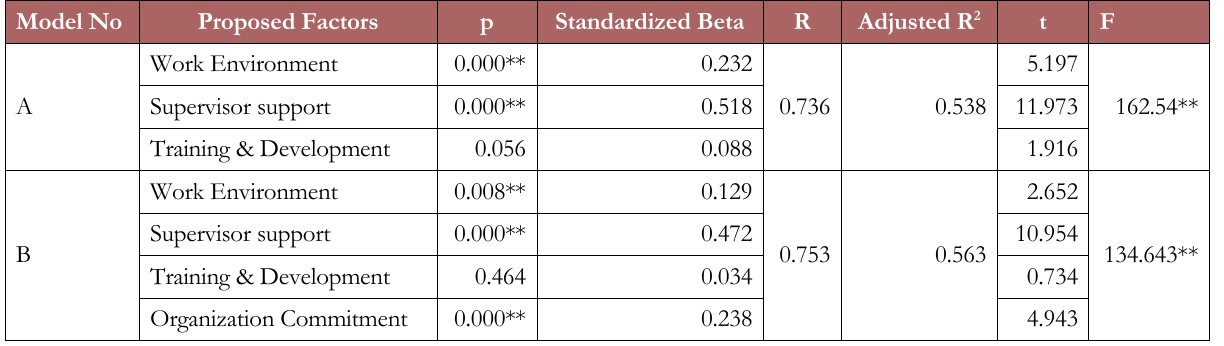
Table 4. Summary of hierarchical multiple regression analysis of employee retention on proposed factors [n =